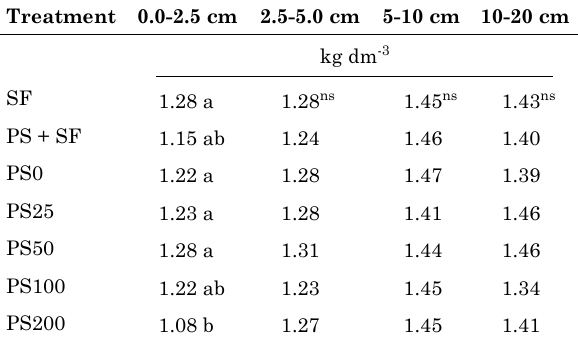
table 1. soil bulk density in the layers 0.0-2.5, 2.5-5.0, 5-10, and 10-20 cm of a typic Hapludox cultivated for nine years with no-tillage maize and oat and annually fertilized with soluble fertilizer (sF), pig slurry (Ps) at rates of up to 200 m 3 ha -1 , and the combination Ps + sF. Mean of four